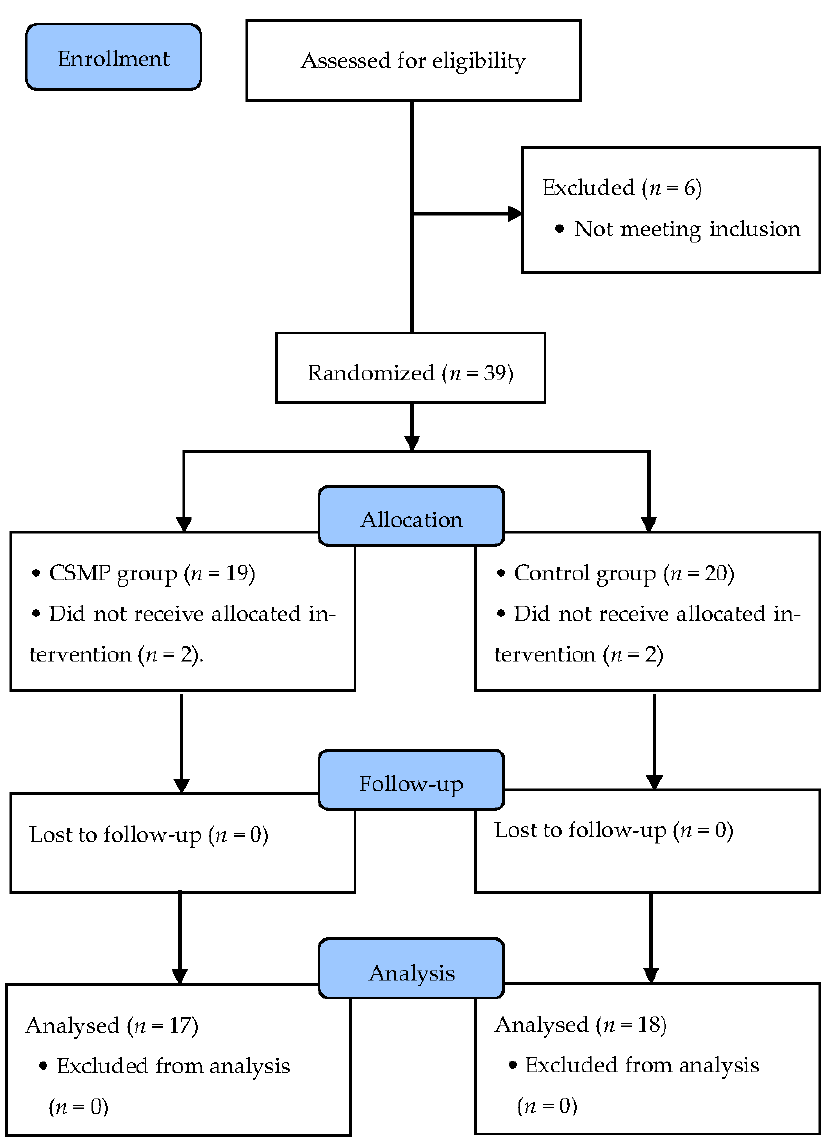
Figure 1. Flow diagram of the study.